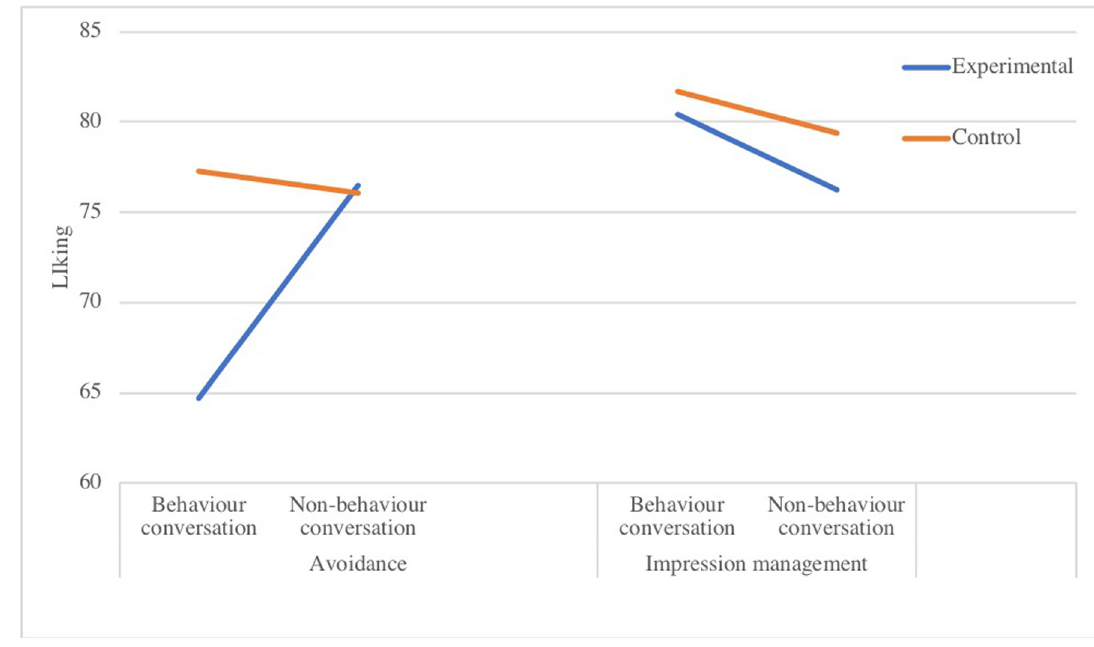
Fig 4. Three-way interaction of safety behaviour type, conversation type and participant type on how much one is liked by one’s partner.